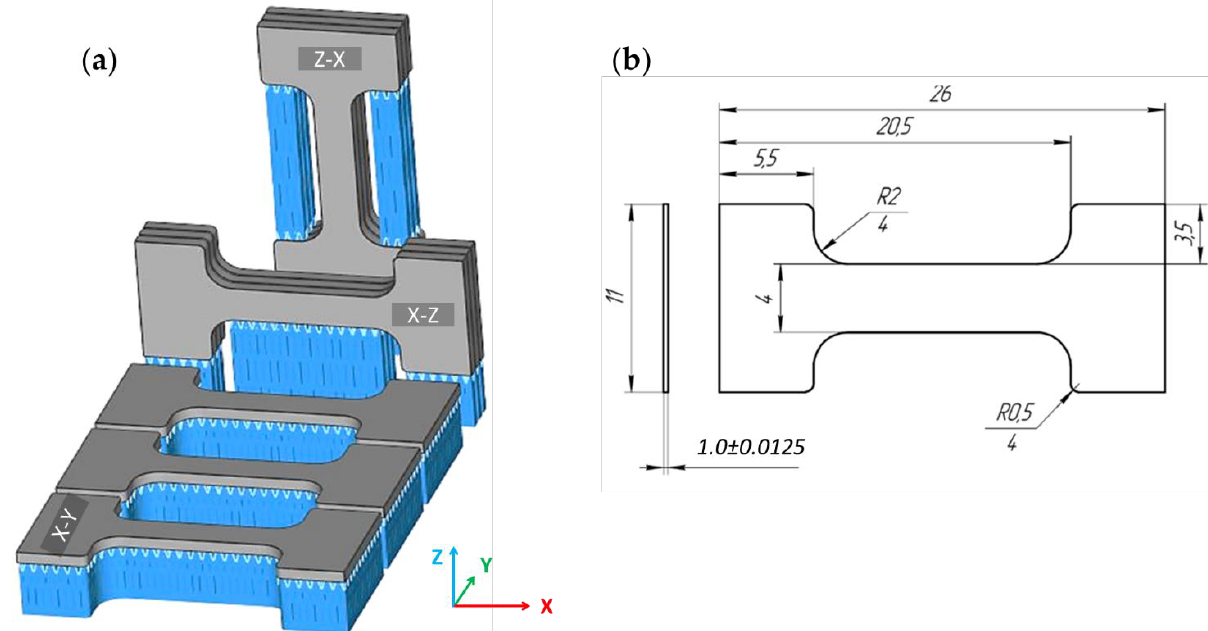
Figure 3. Test samples ( a ) of varying orientation during printing process, X-Y, X-Z and Z-X, shown from front to back, and ( b ) the nominal sample shape and dimensions.